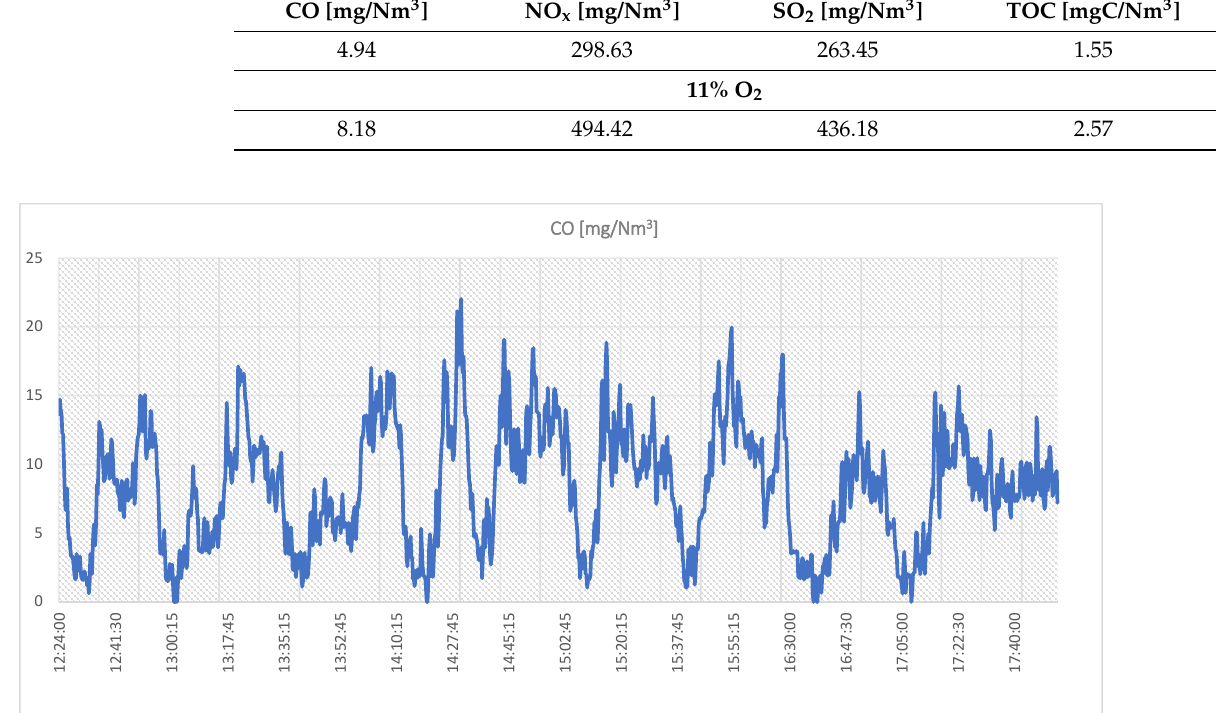
Figure 3 . CO emission trend during combustion test . Figure 3. CO emission trend during combustion